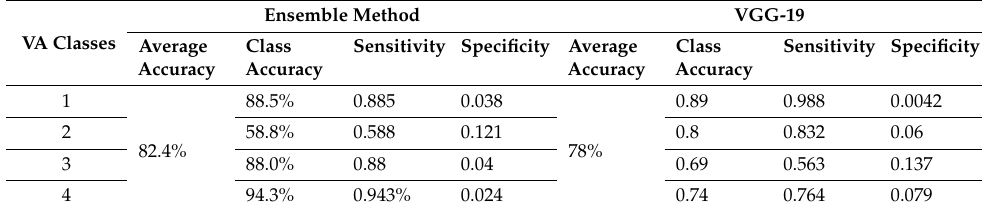
Table 7. Comparison of VA classifiers’ performance based on our ensemble method and